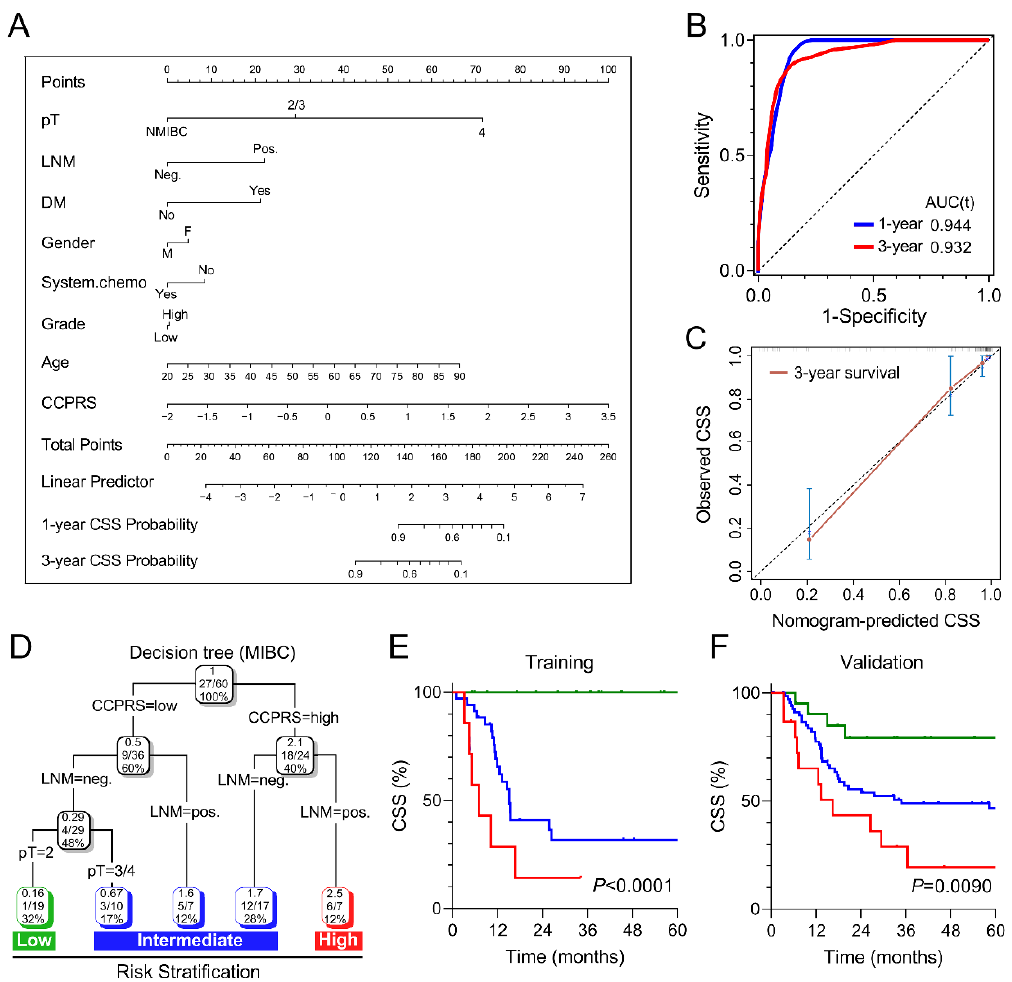
Figure 8. Combination of CCPRS and clinical variables to improve risk assessment and stratification. ( A ) A nomogram was constructed to quantify risk assessment and predict CSS probability for individual patients. ( B ) Time-dependent ROC analysis was performed to evaluate the predictive power of the nomogram for 1-year and 3-year CSS. ( C ) Calibration analysis indicated the nomogram has a high accuracy of CSS prediction. ( D ) An integrated decision tree was generated to optimize the risk stratification for MIBC patients. ( E ) In the training cohort, MIBC patients in the high-risk group exhibited worst CSS compared to other groups ( p < 0.0001). ( F ) Significant di ff erence of CSS was observed among di ff erent risk subgroups in the validation cohort.